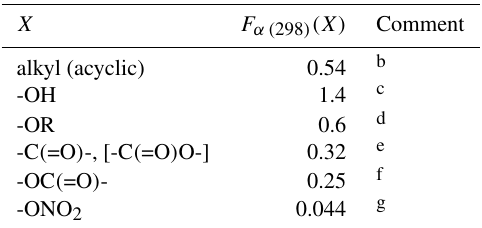
Table 2. Substituent factors, F α( 298 ) (X) , describing the effect of the given substituent at the α carbon atom in R groups in alkenes and in allylic oxygenated compounds at 298K a